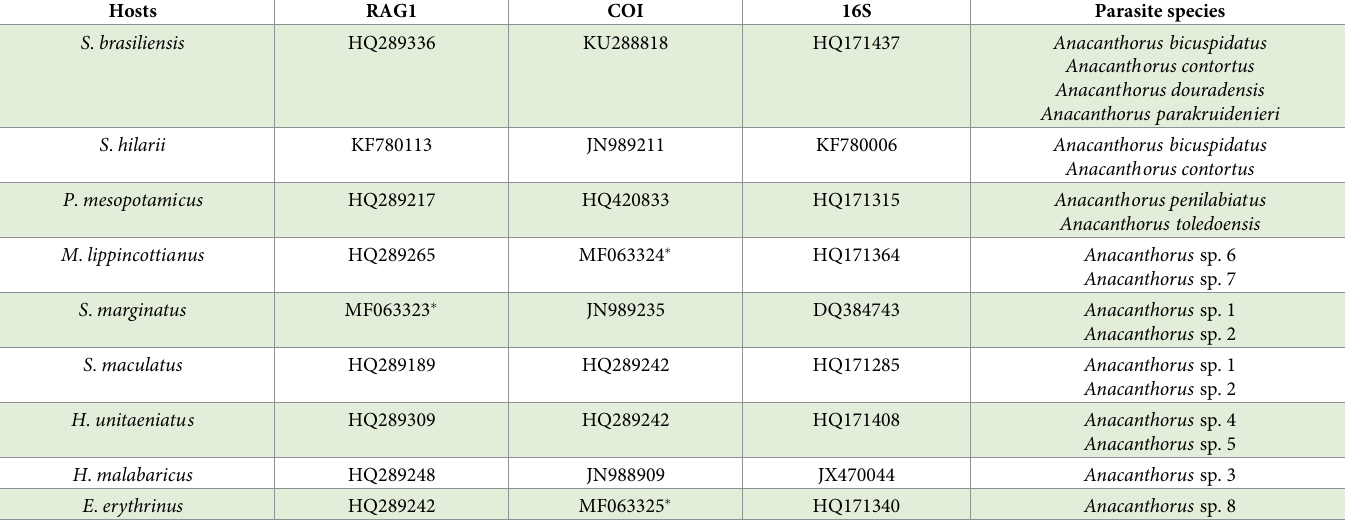
Table 1. GenBank accession numbers of the DNA sequences of genes RAG1, COI and 16S of fish hosts and associated species of Anacanthorus detected in the pres- ent effort on each fish species.